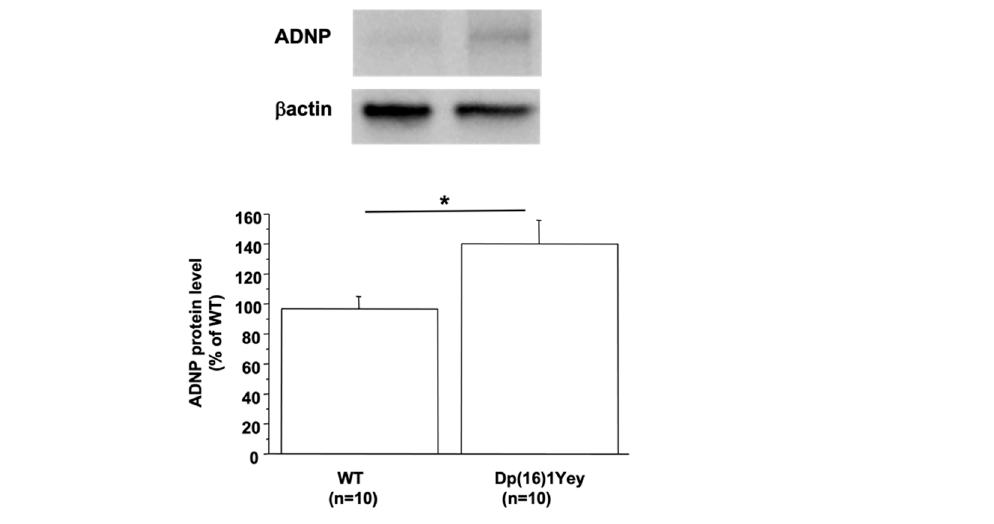
Figure 1. ADNP protein levels in brain of Dp(16)1Yey mice. Western blotting showing ADNP in brain of control (WT) and Dp(16)1Yey mice. Values were obtained by normalization of images from ADNP to β actin (for Western blot) or Ponceau-S coloration (for slot blot). Statistical analysis was done with the Student’s t -test using Statview software. Data were normalized to the mean of control (WT) mice. The results are represented as means ± SEM. n = number of mice. * p < 0.05.